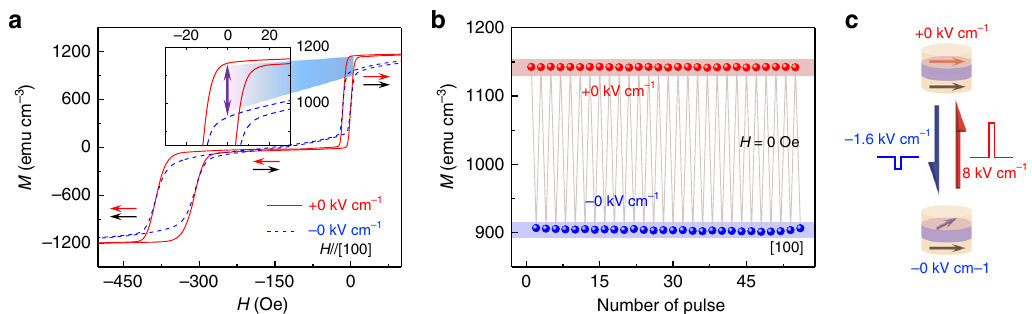
Fig. 2 M-H loops of MTJ under electric fi elds with applied magnetic fi eld along the [100] direction. a M-H loops of MTJ for E = ±0 kV cm − 1 , respectively. The arrows denote the magnetization con fi gurations for corresponding magnetic fi elds. The inset presents electric- fi eld-induced magnetization variation of the free layer around zero magnetic fi eld. b Reversible and remarkable magnetization switching induced by successive application of electric- fi eld pulses at H = 0 Oe for case II in Fig. 1d. c The magnetization con fi gurations of MTJ at E = ±0 kV cm − 1 in b . These two magnetization states can be reversibly switched by 8 kV cm − 1 and – 1.6 kV cm − 1 electric- fi eld in both the CoFeB layers align in the fi lm plane, resulting in full applying symmetric bipolar electric fi elds within ±8 kV cm − 1 , a P-E loop of PMN-PT presents a typical hysteresis loop. The corresponding strains ε x and ε y versus electric fi eld curves mea- sured along the [100] and [011] crystallographic directions of PMN-PT, respectively, display normal butter fl y-like behaviors, with two peaks around E C and without remanent strain (Sup- plementary Fig. 6b). As long as the electric fi eld exceeds E C , FE polarization was switched to the out-of-plane. Consequently, the large strains around E C dramatically descend, leading to the peaks, which indicates the close relationship between the strain peaks and FE polarization switching. Alternatively, when mea- sured between 8 kV cm − 1 and − 1.6 kV cm − 1 in Fig. 3b, the strain peak can persist only if the electric fi eld almost reaches E C (but remains smaller than E C ) and turns back instead, leading to a loop-like non-volatile strain. Due to the converse piezoelectric effect, an electric fi eld induces tensile and compressive strain along the [011] and [100] direction, respectively, in consideration of their opposite piezoelectric coef fi cients 53 . The effective aniso- tropic strain ε y − ε x that is responsible for the modi fi cation of magnetic anisotropy of the free layer is shown in Supplementary Fig. 6c. Note that the electric- fi eld-dependent RA in Fig. 1e dis- plays a trend similar to the anisotropic strain curve in Supple- mentary Fig. 6c, which indicates the important role of strain- mediated magnetoelectric coupling. The polarization under a corresponding electric fi eld range with a minor loop is shown in Fig. 3a. After applying electric fi eld 8 kV cm − 1 , the polarization points to the out-of-plane direction with a large polarization at E = + 0 kV cm − 1 (Fig. 3c). The polarization then dramatically changes to small values around E C, revealing the in-plane FE polarization, which remains almost the same while sweeping the electric fi eld from − 1.6 kV cm − 1 to − 0 kV cm − 1 (Fig. 3d). Fur- ther increasing the electric fi eld from 0 to 8 kV cm − 1 , the polarization is gradually saturated and goes back to the out-of- plane again at + 0 kV cm − 1 . This evolution of FE polarization has also been con fi rmed by piezoresponse force microscopy (PFM) 54,55 . Thus, this asymmetric electric fi elds technique (minor loop) is effective at stabilizing the metastable in-plane FE polarization state and achieving bistable polarization states at zero electric fi eld, as illustrated in Fig. 3c, d. This reversible conversion between the out-of-plane ( + 0 kV cm − 1 ) and in-plane ( − 0 kV cm − 1 ) polarization of PMN-PT is the origin of the non- volatile strain in Fig. 3b, which has been used to control only FM layer ’ s magnetism 46 , ferromagnetic resonance 54 , Verwey transi- tion 55 , etc. This non-volatile strain is reversible and stable with a good endurance (Supplementary Figs. 6d, 6e and 6f), suggesting the well reproducible ferroelectric domain switching between the in-plane and the out-of-plane.